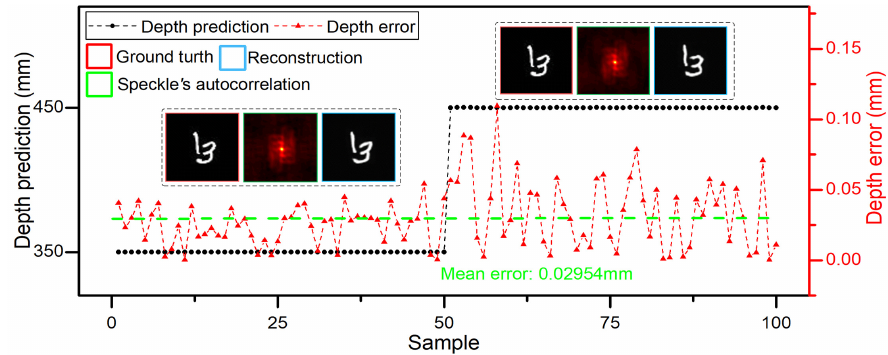
Figure 5. Locating and imaging results with the different object size and the same imaging size.